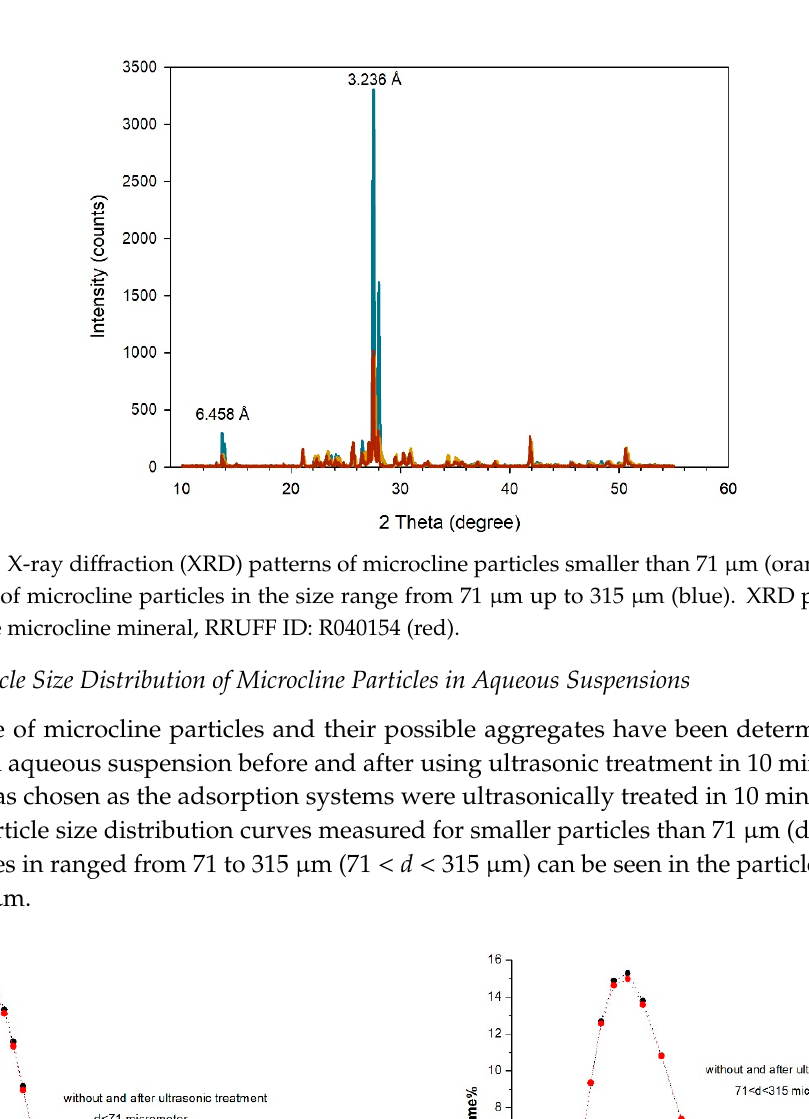
Table 1. Statistical parameters of the studied microcline particles (The mathematical “method of moments” was calculated following Friedman and Johnson’s [26] functions) .